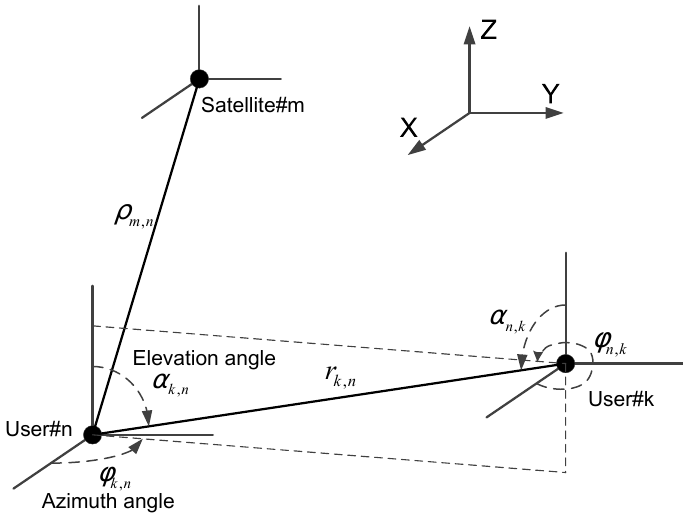
Figure 1. Three-dimensional satellites and user